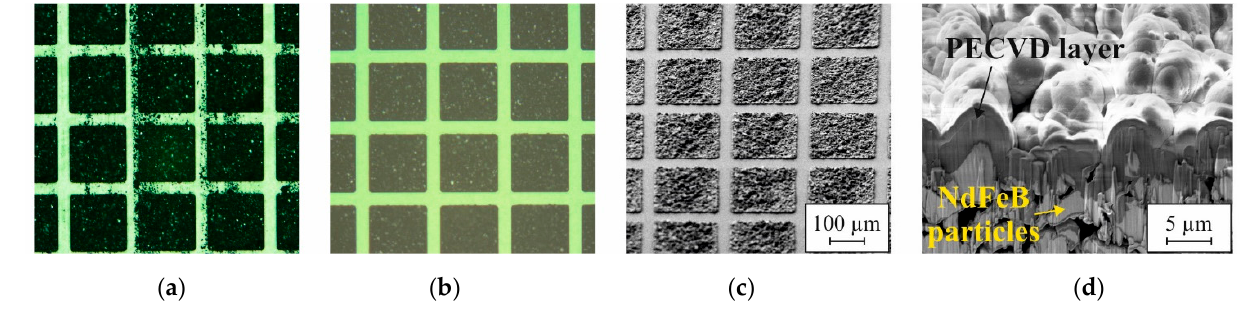
Figure 6. Photographs of a micromagnet array ( a ) after agglomeration of the NdFeB particles and ( b ) after surface conditioning. The SEM micrograph in ( c ) shows a micromagnet array after passivation with 3 µm PECVD silicon oxide and ( d ) a FIB cross-section through such a pixel. Finally, the micromagnets are magnetized on the wafer-level. A custom-made magne-